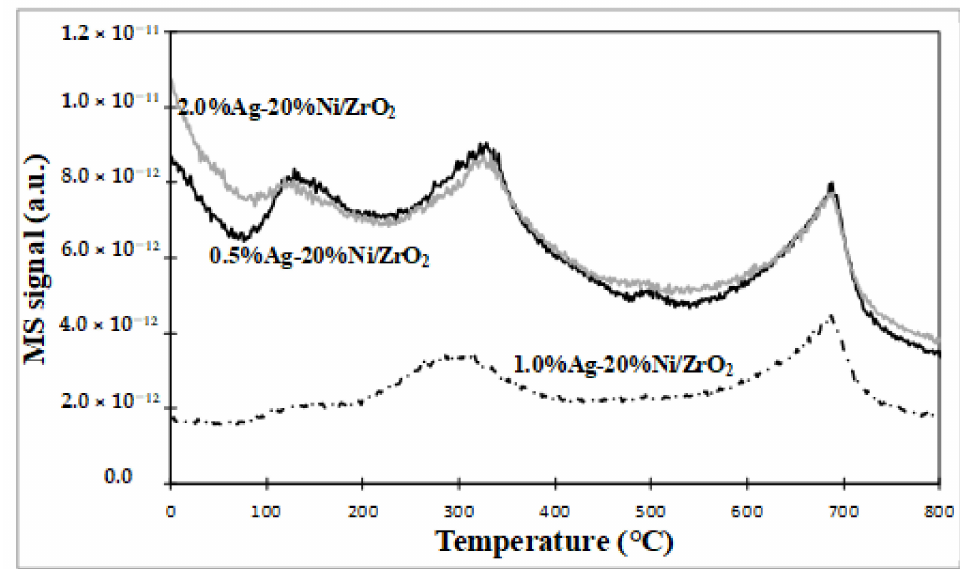
Figure 14. The MS profiles for m / z = 44 (CO 2 ) of bimetallic Ag-Ni / ZrO 2 catalysts after oxy-steam reforming of methane reaction.